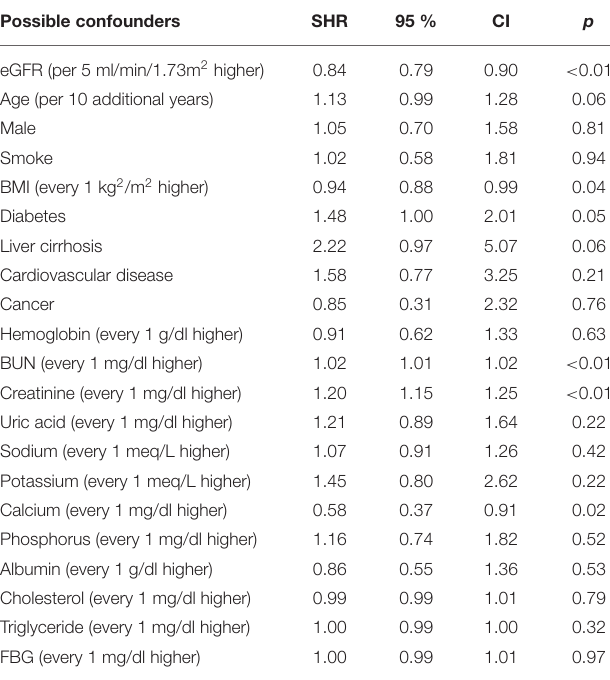
TABLE 3 | Subdistribution hazard ratios (SHRs) of possible confounders for tuberculosis in univariate competing-risks analysis. Possible confounders